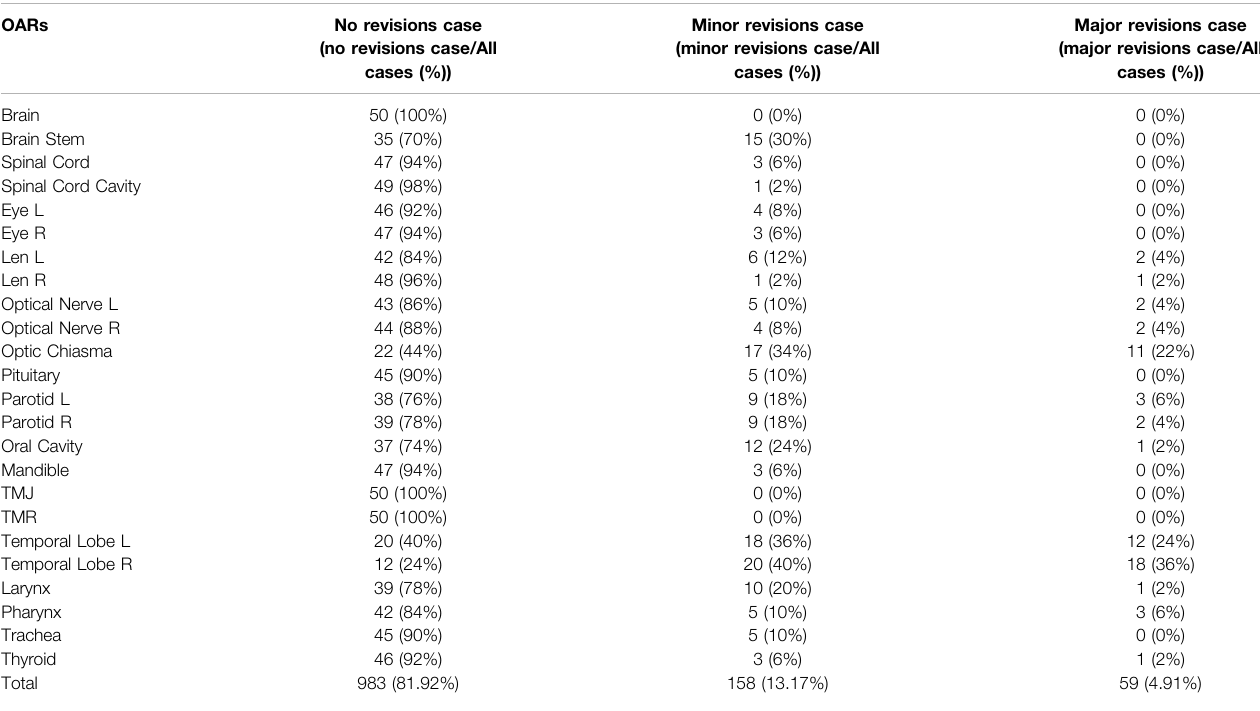
TABLE 8 | The statistics for different OAR modi fi cations by the senior oncologist in 50 cases after automatic delineation by SEB-Net.